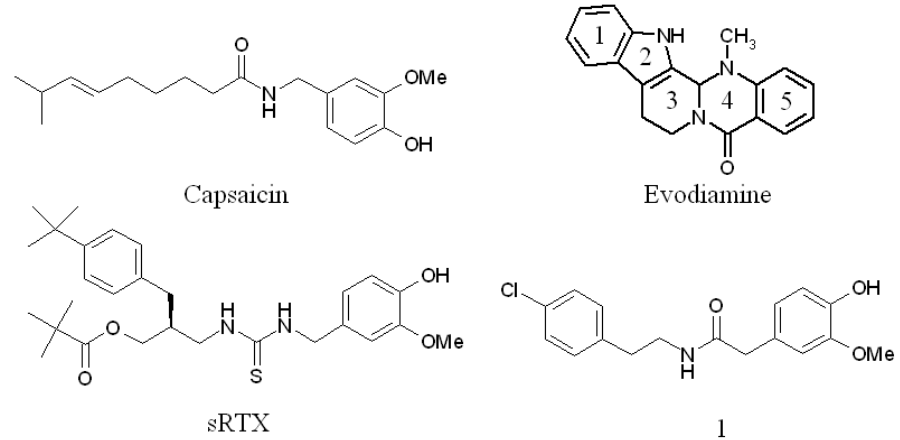
Figure 1. Structures of capsaicin, evodiamine, sRTX and compound 1.